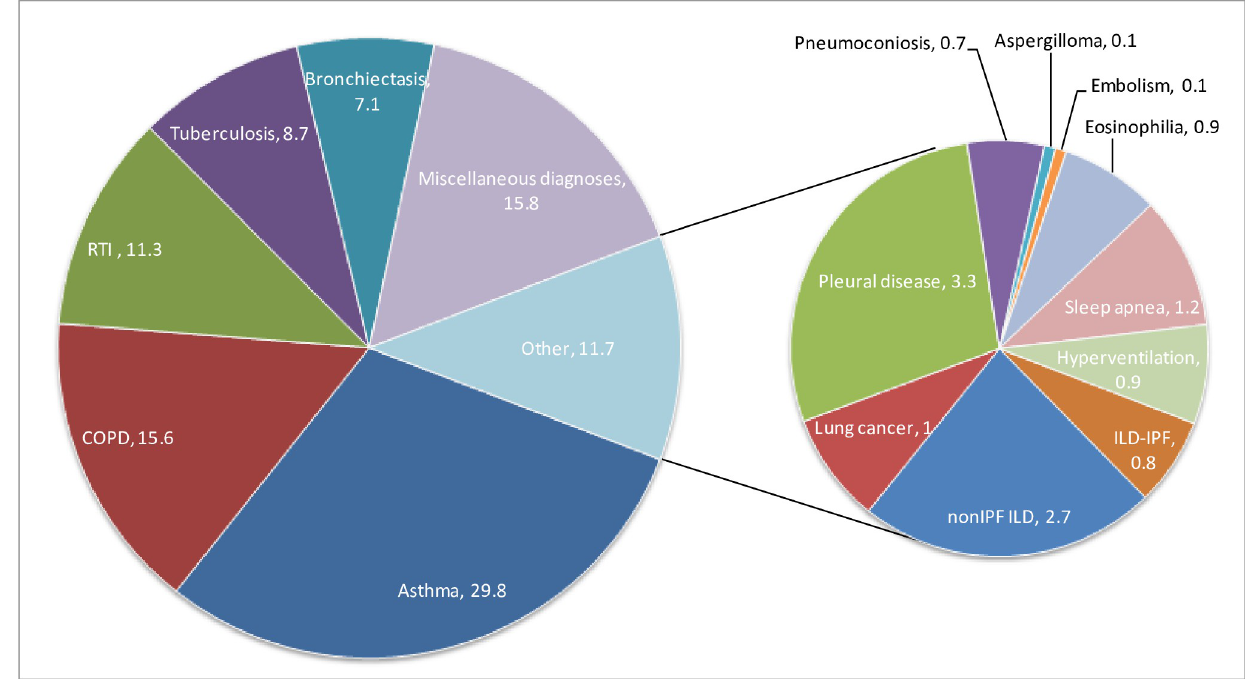
Fig 3. Respiratory diagnoses in the SWORD study population. Asthma, COPD, RTI, tuberculosis and bronchiectasis were the major respiratory diagnoses. As per the SWORD study protocol all the ICD-10 based respiratory diagnoses were included. Other miscellaneous respiratory diagnoses are not shown. (Abbreviations: COPD = chronic obstructive pulmonary disease, HVS = hyperventilation syndrome, RTI = respiratory tract infections, IPF = idiopathic pulmonary fibrosis).